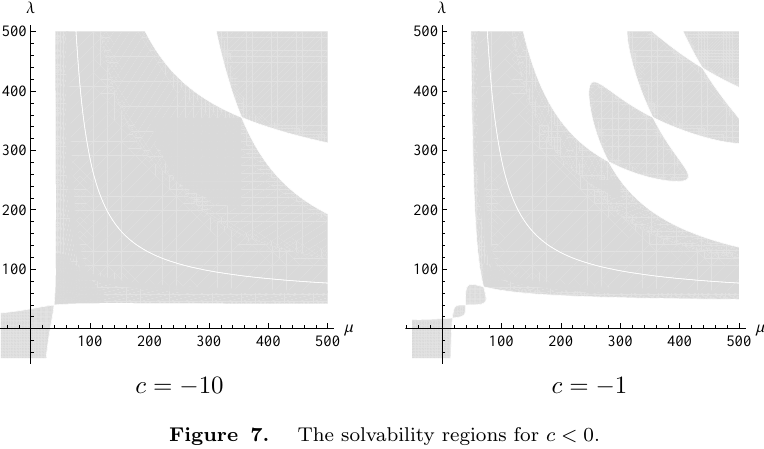
Figure 7. The solvability regions for c < 0.